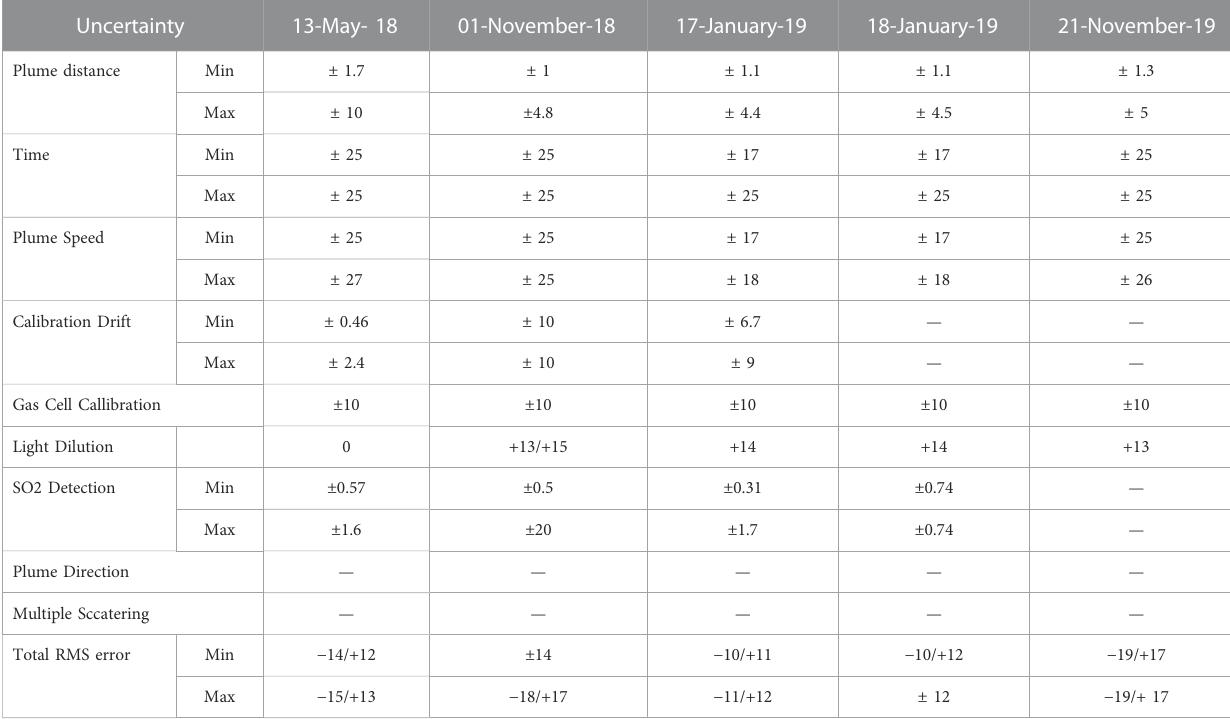
TABLE 2 Uncertainties in each measurement. Total RMS error (root mean square) is included (%). (-) represent a despicable error.